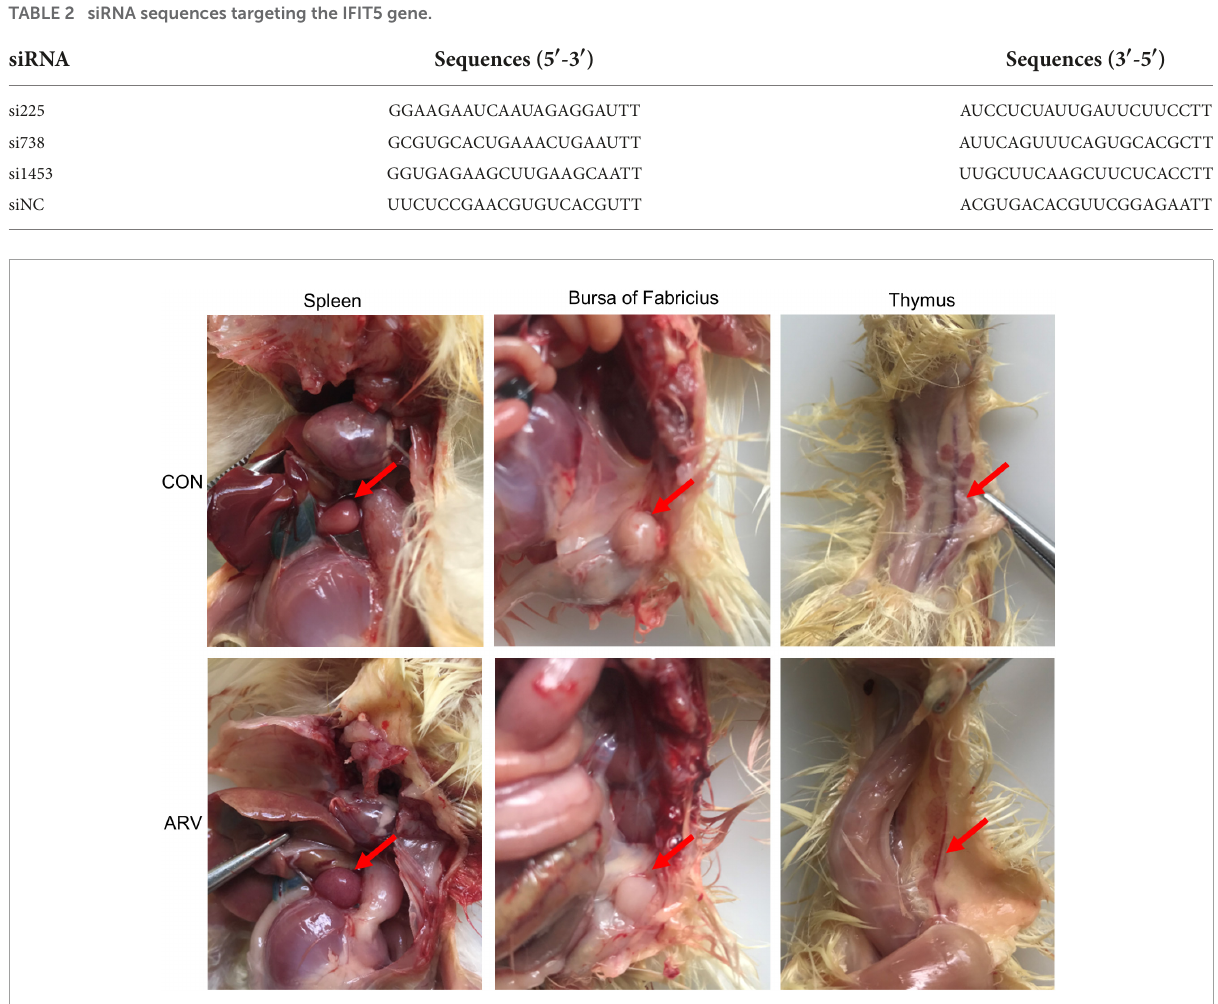
FIGURE1 Pathological changes in the spleen, bursa of Fabricius, and thymus in SPF chickens infected with ARV. In the control group (CON), SPF chickens were injected with 0.1 ml of PBS into the footpad. In the experimental group (ARV), ARV strain S1133 (10 4 TCID 50 /0.1 ml) was injected into SPF chickens through the footpad. After ARV infection of SPF chickens, dissection results revealed edema in the spleen and atrophy in the bursa of Fabricius and thymus.